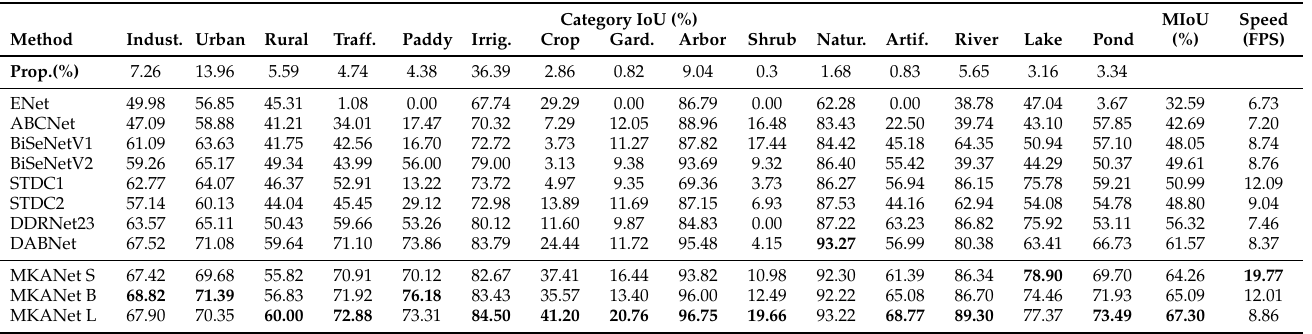
Comparison of MKANets with other state-of-the-art lightweight networks on the GID dataset.